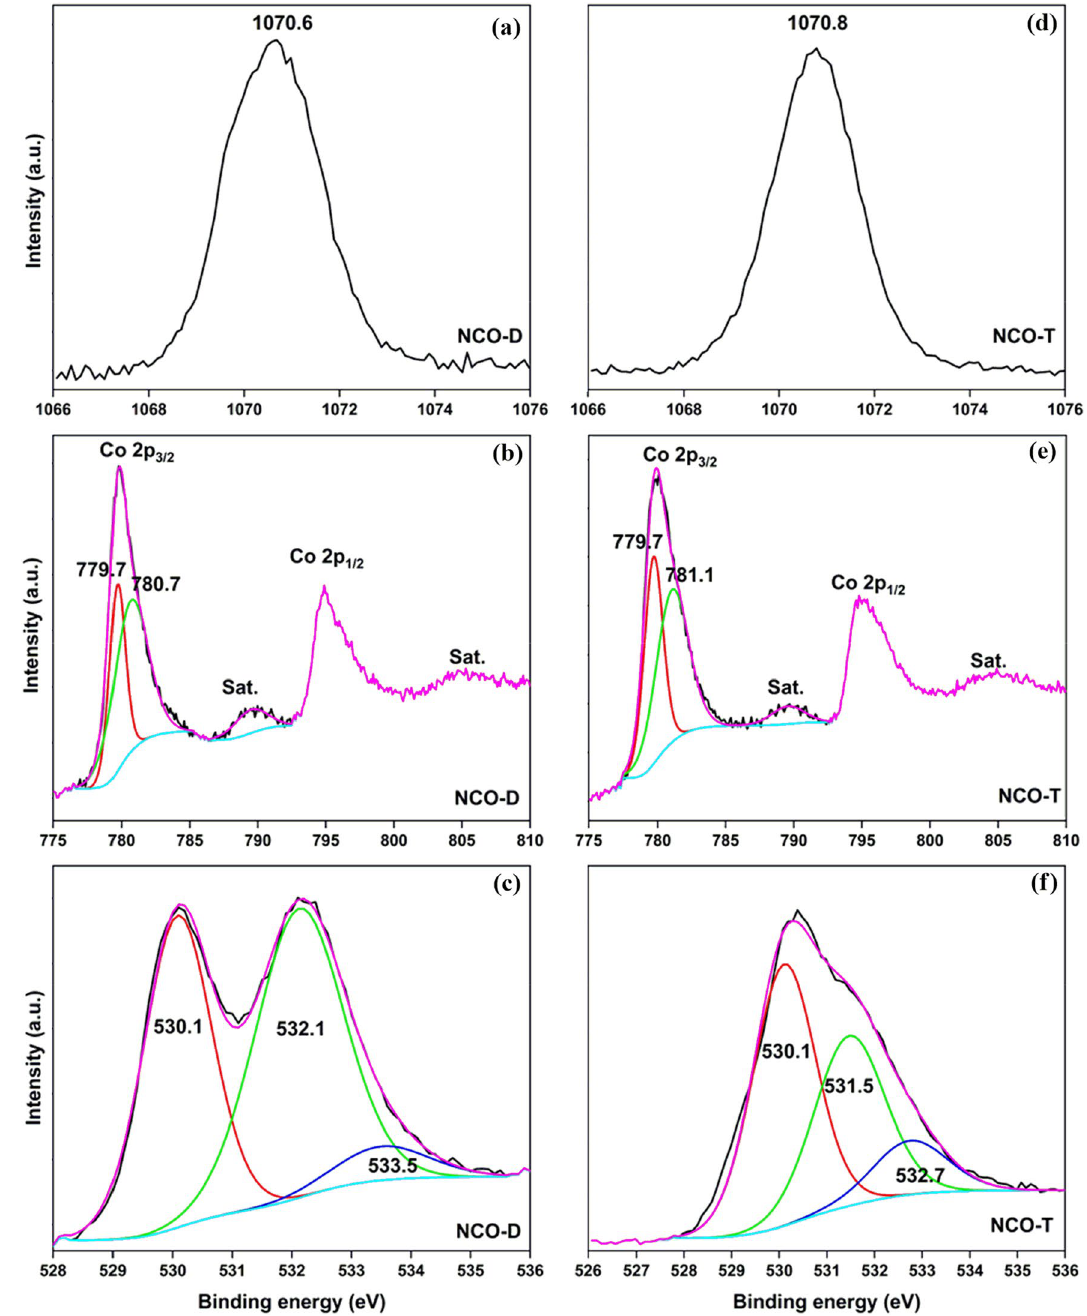
Figure 3. HRXPS ( a ) Na 1s; ( b ) Co 2p; ( c ) O 1s spectra of NCO-D; ( d ) Na 1s; ( e ) Co 2p; ( f ) O 1s spectra of Co 2p 3/2 spectrum deconvoluted into two contributions at 781.1 and 782.7 eV for Co 3+ (49.1%) and Co 2+ (50.9%), respectively, with two satellites at 785.0 and 788.2 eV 24 . The HRXPS O 1s spectrum of CoBDC has four contri- butions at 531.5, 532.5, 533.7, and 535.4 eV for O–Co/O–Na, O–C=O, O–H, and H 2 O, respectively (Fig. S4c) 42 . For CoBTC, the HRXPS C 1s spectrum deconvoluted into four peaks at 284.7, 285.9, 288.3, and 290.0 eV for C=C/C–H, C–O, –COOCo, and –COONa, respectively (Fig. S4d). In the HRXPS Co 2p spectrum of CoBTC, the Co 3+ and Co 2+ peaks were observed at 781.0 and 782.5 eV with 48.7 and 51.3% contribution, respectively (Fig. S4e). The HRXPS O 1s spectrum of CoBTC has peaks at 531.5, 532.5, and 533.8 eV for O–Co/O–Na, O–C=O, and O–H, respectively (Fig. S4f). The HRXPS spectra of NCO-D and NCO-T are shown in Fig. 3, and the curve-fitting parameters are listed in Tables S6 and S7. The HRXPS Na 1s spectra of NCO-D (Fig. 3a) and NCO-T (Fig. 3d) has a peak at 1070.6 and 1070.8 eV, respectively, for Na + ions 43 . The HRXPS Co 2p spectrum of NCO-D has peaks at 779.8 and